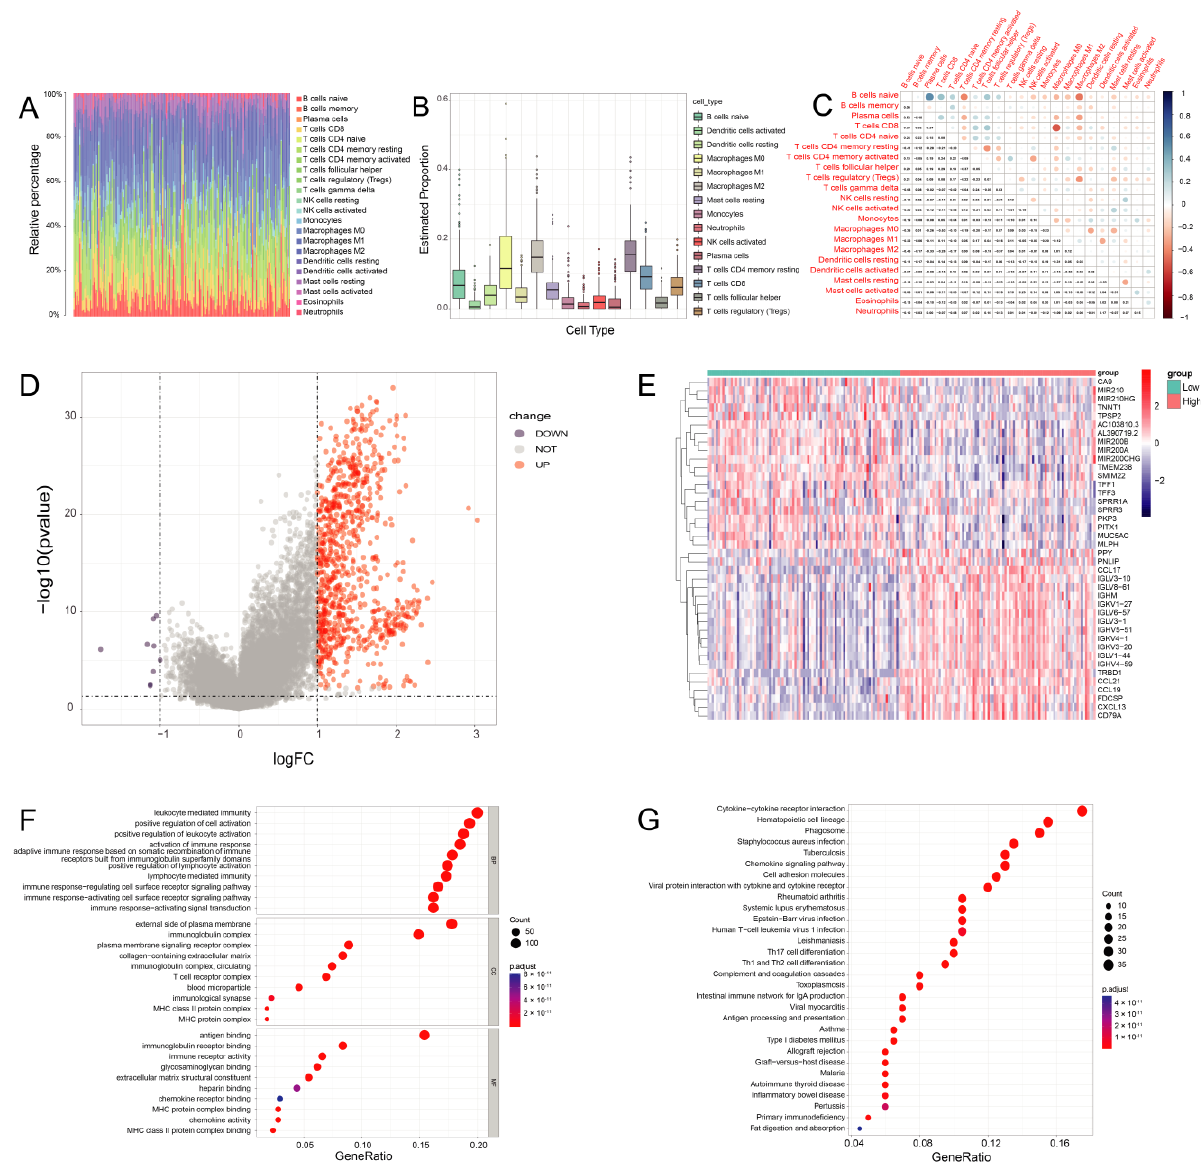
Figure 5. The immune cells composition of PDAC. ( A ) Bar plot shows the proportion of 22 types of TICs in PDAC tumor samples. The column names of the plot were sample IDs. ( B ) The estimated proportion of 22 types of TICs in PDAC tumor samples. ( C ) Heatmap shows the correlation between 22 kinds of TICs and numerics in each tiny box, indicating the p -value of the correlation between two cells in PDAC. ( D ) Volcano plot for DEGs. The blue and red dots represented the significantly downregulated and upregulated genes, respectively, and the gray dots represented the genes without differential expression. ( E ) Heatmap for DEGs generated by comparison of the high-score group vs. the low-score group in ImmuneScore. The row name of the heatmap is the gene name, and the column name is the IDs of samples not shown in the plot. DEGs were determined by the Wilcoxon rank sum test, with FDR < 0.05 and |log2 FC | > 1 as the significance threshold. ( F , G ) GO and KEGG enrichment analyses for DEGs in PDAC, and terms with p and q < 0.05 were believed to be enriched